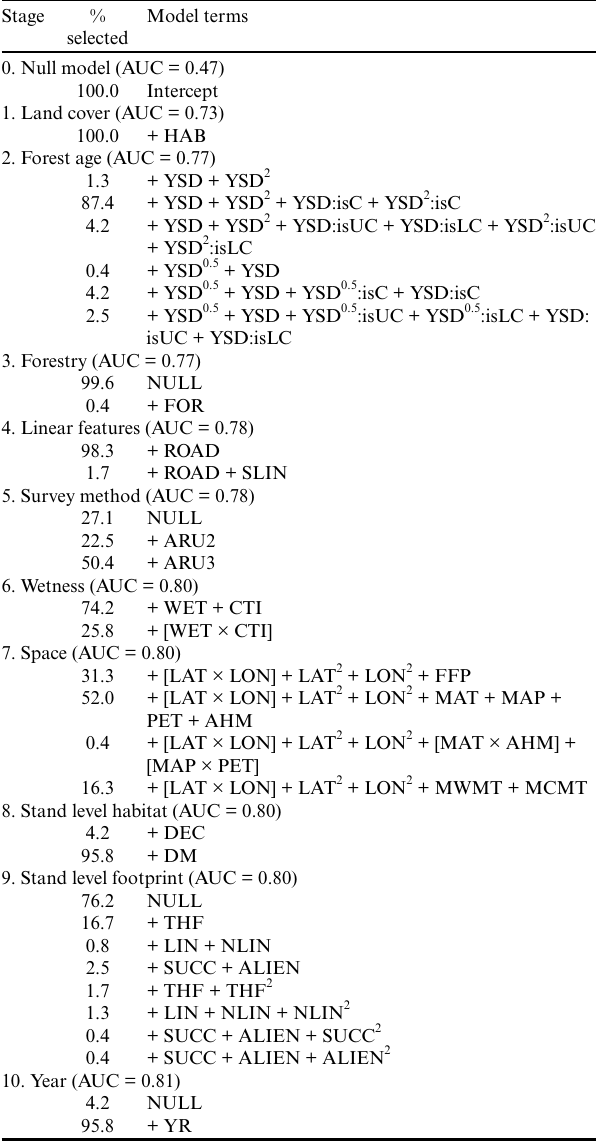
Table 2 . Models pertaining to each stage of the branching hierarchy model building process. Descriptions of variable name abbreviations are provided in the Table 1. Colon (:) means interaction, terms in square brackets with a multiplication sign (×) expand to main effects and interaction term (i.e., A × B = A + B + A:B); NULL = no terms added at that stage. Selection percentage refers to the number of times the model terms were selected out of 240 bootstrap runs. Models that were not selected at least once were omitted from the table. Area under the receiver operating characteristic curve (AUC) is noted for each model stage based on 10% holdout validation